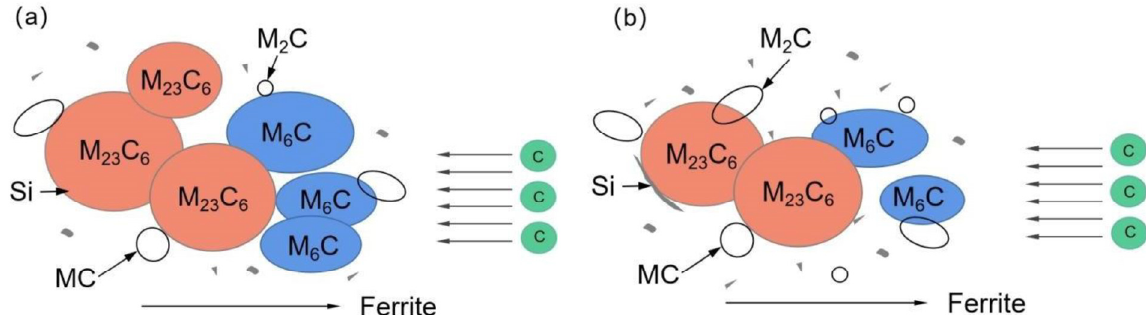
Figure 11. Thermodynamic calculations by Thermo-Calc software with TCFE10 database: ( a , b ) 300–1200 °C full views,( c , d ) 300–1200 °C partial enlarged views.